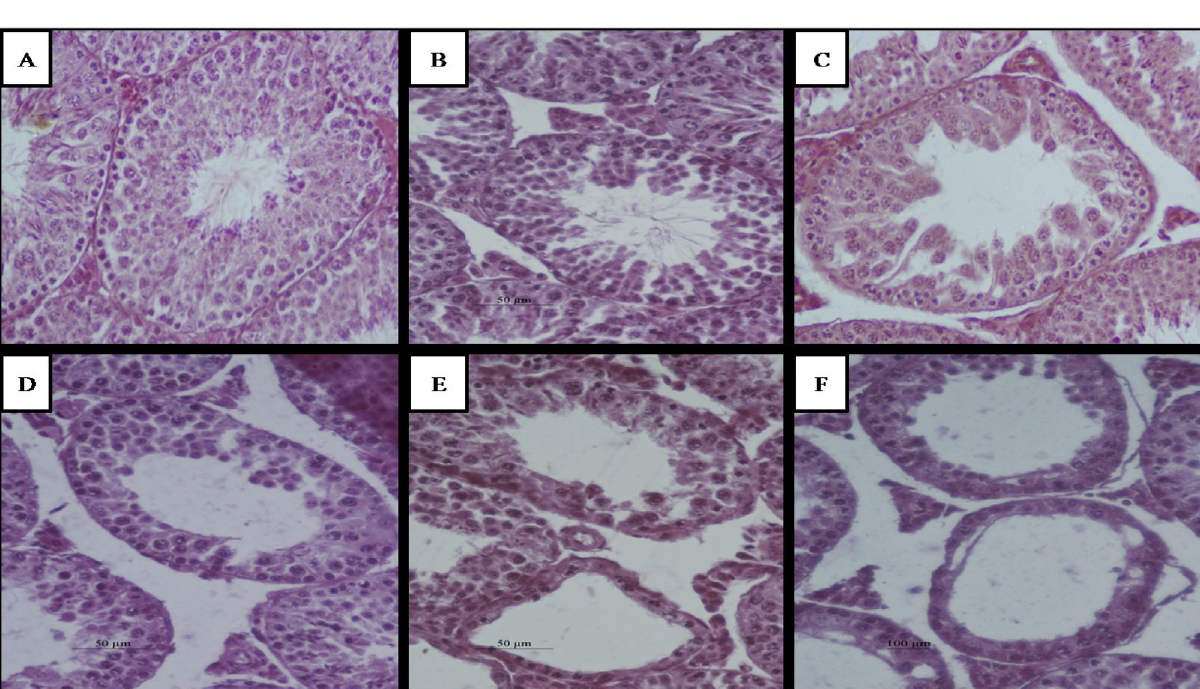
FIGURE 3 - Representative photomicrographs of testis sections (400X: H&E). The testis section from control mice evidenced different stages of spermatogenesis (A). In the AEAM treated testis showed alterations in spermatogenesis (B). CPA treated mice testis showed atrophy of seminiferous tubules, degenerated germ cells and shrunken seminiferous tubules, compared with the normal cellular content of the control group (C). In the CPA + AEAM showed, the damage to the seminiferous tubules was considerably more severe